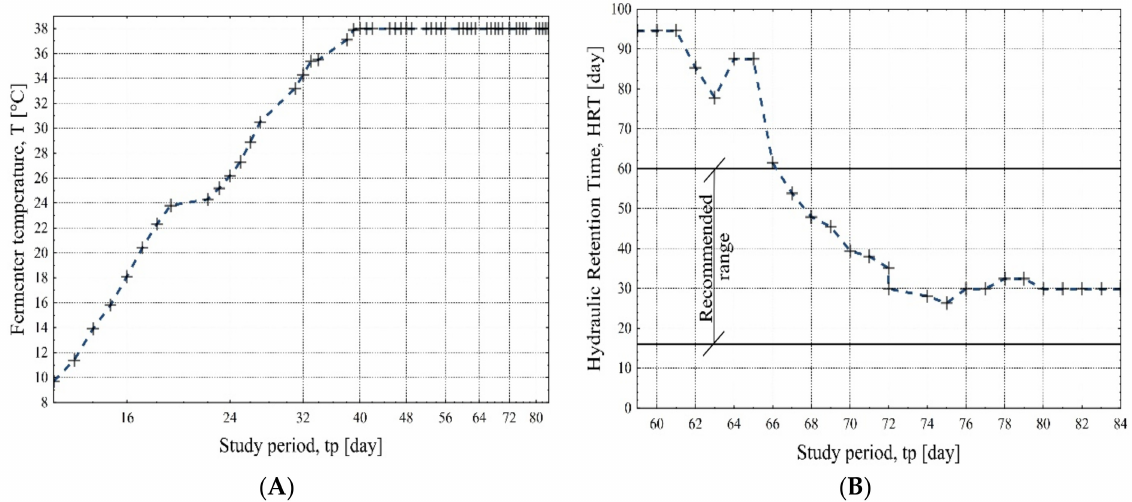
Figure 2. Variation in temperature (T) ( ◦ C) ( A ) and hydraulic retention time (HRT) (day) ( B ) as a function of operating time from the start of the biogas plant tp (day) using water, corn silage, a mixture of pig and cattle liquid manure and inoculated